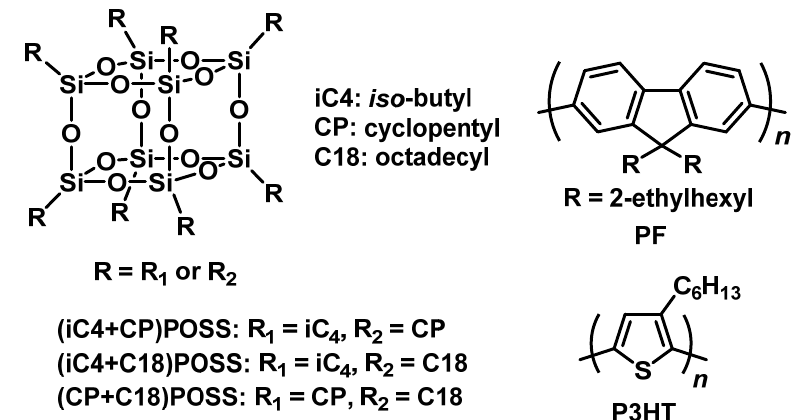
Table 1. Optical property changes by hybrid formation with POSS a